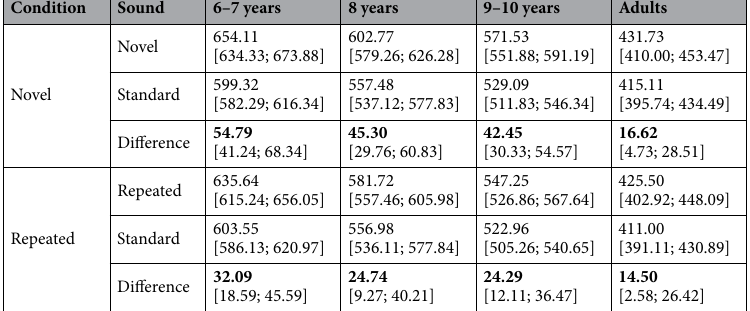
Table 2. Model-implied RTs and distraction effects. The values in the table represent the predicted (or model- implied) RTs and distractions effects (i.e., differences distractor RT–standard RT). These may be interpreted as if they were mean RT for the respective factor combination. The main advantage of the LMM in this context is that it easily provides 95% confidence intervals (provided in square brackets) that take the repeated measures structure of the data and the heteroscedasticity between groups into account. All groups showed significant distraction effects the novel and repeated condition (marked in bold).